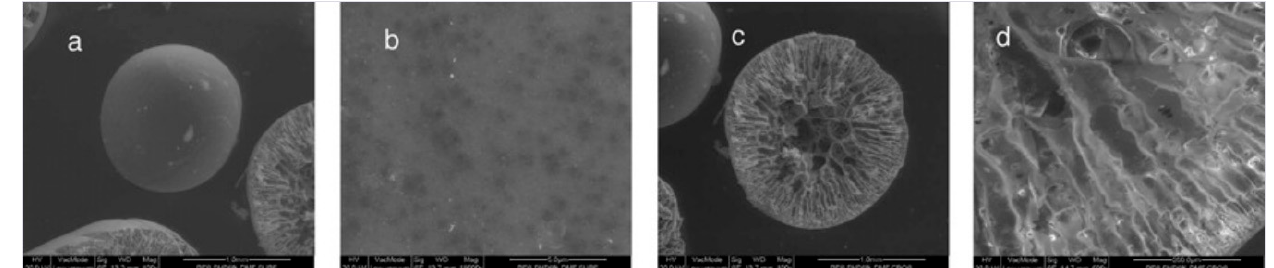
Figure 7. SEM microstructures of 10 wt.% PES/DMF/6 wt.% PVP K17 MCs prepared by using the phase inversion technique: ( a ) surface (100×), ( b ) surface magnification (20,000×), ( c ) cross-section (100×), and ( d ) magnified cross-section (500×) [54].